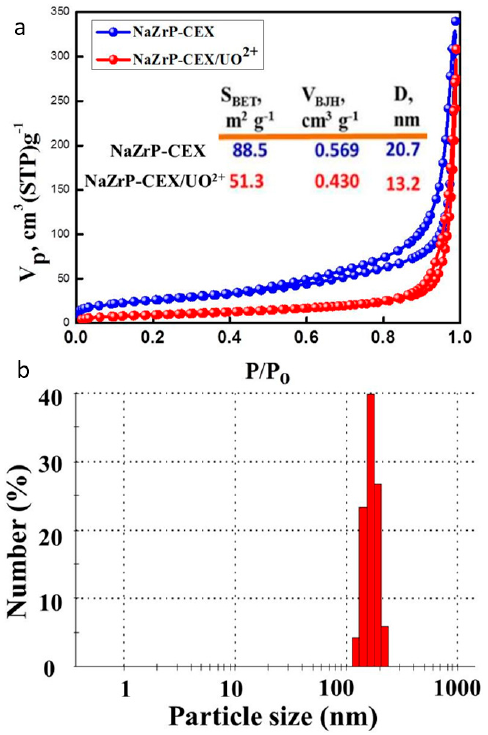
Figure 2. ( a ) N 2 adsorption-desorption isotherm; surface area (S BET ), pore volume (V BJH ) and pore diameter (inset). ( b ) Particle size distribution of the mesoporous NAZrP-CEX